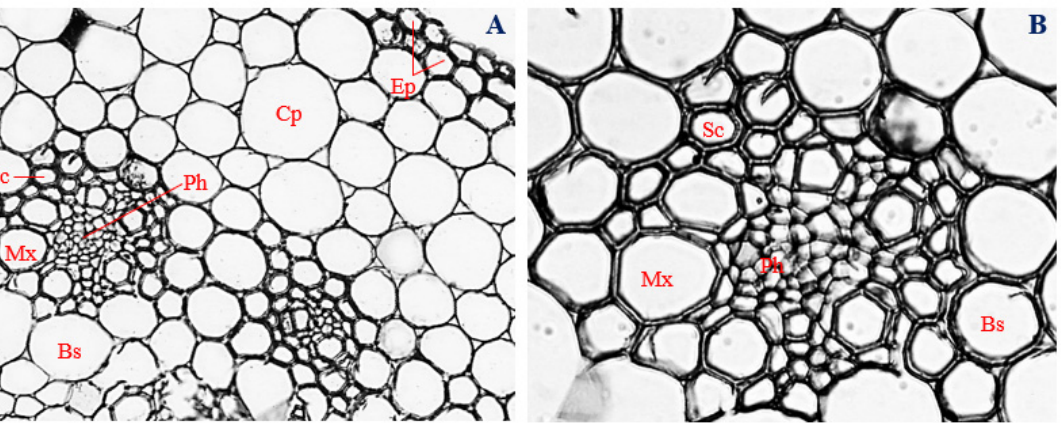
Figure 7. The transverse section of a corn stem infected with endophytic Fusarium sacchari . ( A ) Mag- nification 200×; ( B ) magnification 400×. Ep, epidermis; Cp, cortical parenchyma; Sc, sclerenchyma; Ph, phloem; Mx, metaxylem; and Bs, bundle sheath.